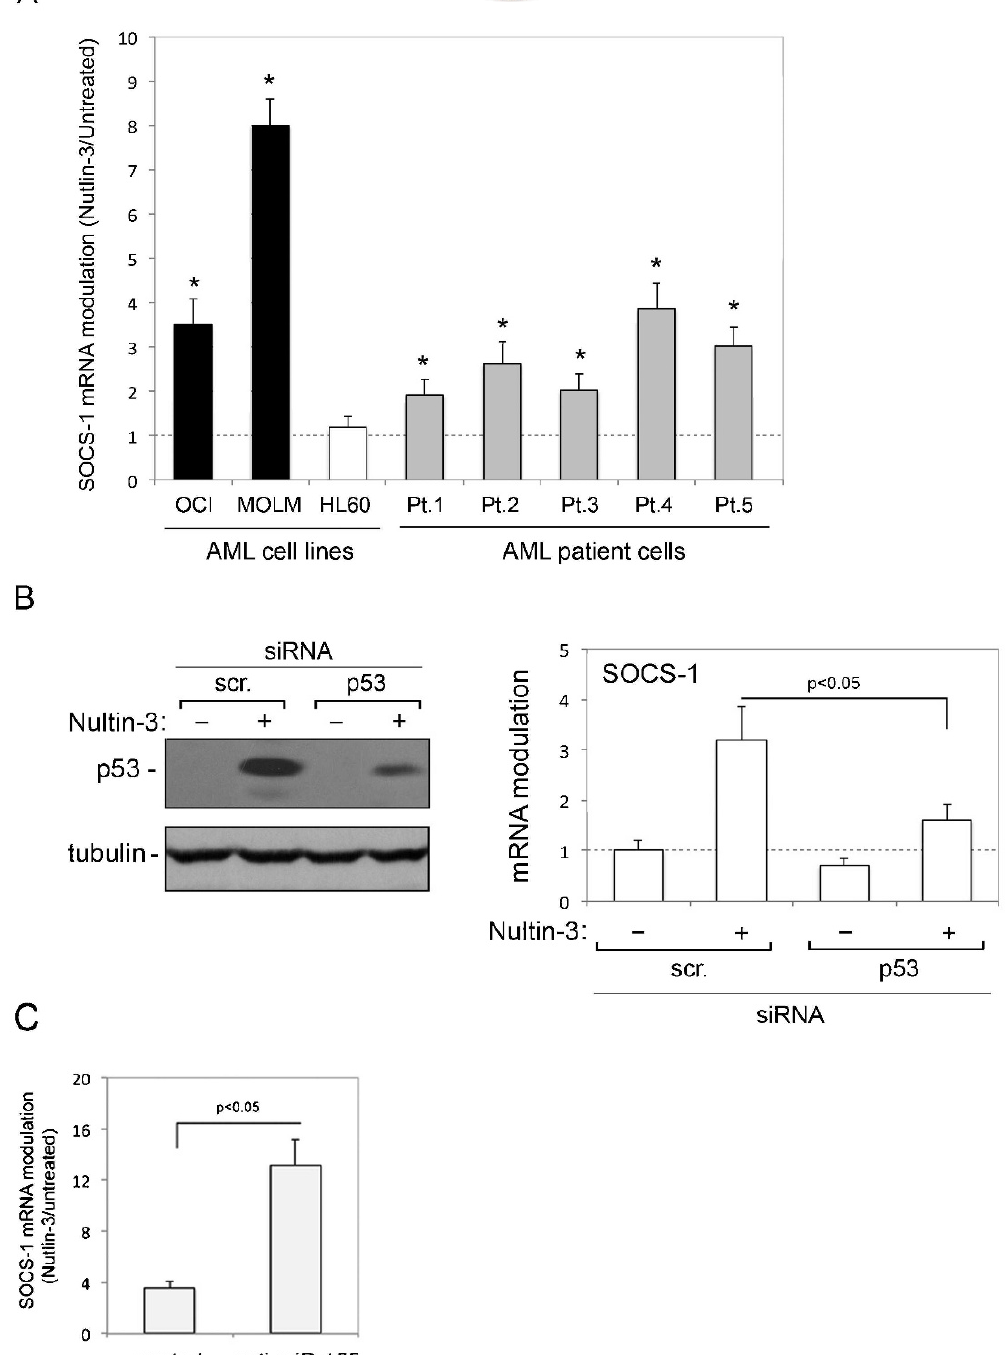
Figure 1 - Transcriptional upregulation of SOCS-1 by Nutlin-3 in AML cells. In A , AML cell lines and primary AML patient (Pt.) cells were exposed to Nutlin-3 (10 m M). Levels of SOCS-1 mRNA were analyzed by quantitative RT-PCR. The results are expressed as the fold of increase in SOCS-1 modulation by Nutlin-3 after 24 hours of treatment with respect to the control untreated cultures (set to 1) (hatched line). Data are reported as the mean ¡ SD of the results from at least three experiments, each performed in triplicate. In B , OCI cells were transfected with control scrambled (scr.) siRNA or p53 siRNA before treatment with Nutlin-3. p53 protein levels were analyzed by Western blot, and tubulin staining is shown as the loading control. Representative examples of Western blot results, from three independent experiments are shown. In parallel, levels of SOCS-1 mRNA wereexpressed as the fold increase with respectto the scrambled control transfected cultures. In C , OCI cells transfected with either hsa-miR-155 anti-miR oligo or miR negative control oligo were exposed to Nutlin-3 and SOCS-1 mRNA was expressed as the fold increase in modulation. Asterisks, p , 0.05 with respect to the untreated cultures or to the scrambled control transfected